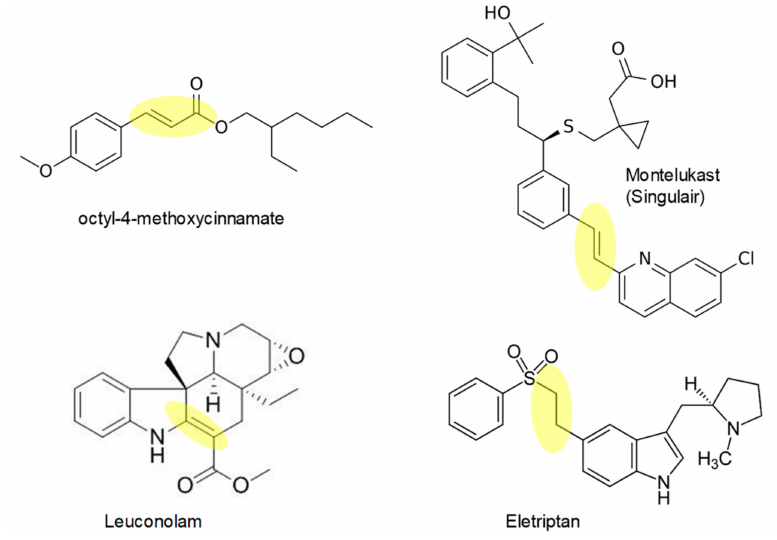
Figure 1. Pharmaceuticals synthesized by using Heck cross-coupling